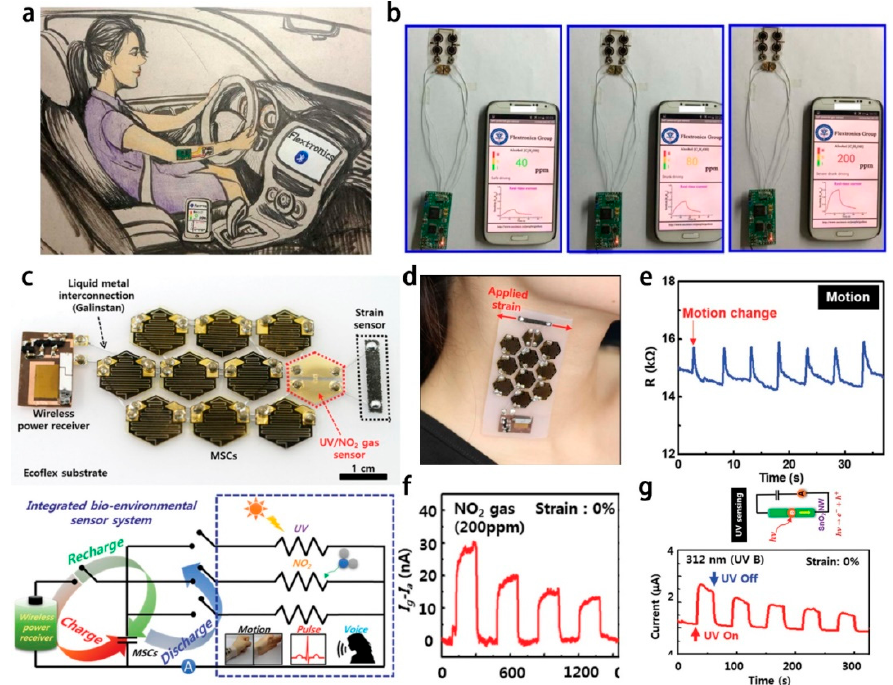
Figure 11. ( a ) Picture of a subject wearing the individual MSC array-gas sensor-analysis unit; ( b ) Real-time C 2 H 5 OH concentration analysis/display; The figure has been reproduced with permission from Elsevier [69]; ( c ) Photography and circuit diagram of the multifunctional integrated system; ( d ) Digital image of the prepared integrated devices; ( e ) The pressure sensor behavior; ( f ) The gas sensor behavior; ( g ) The photo response of the devices. The figure has been reproduced with permission from Wiley [66].